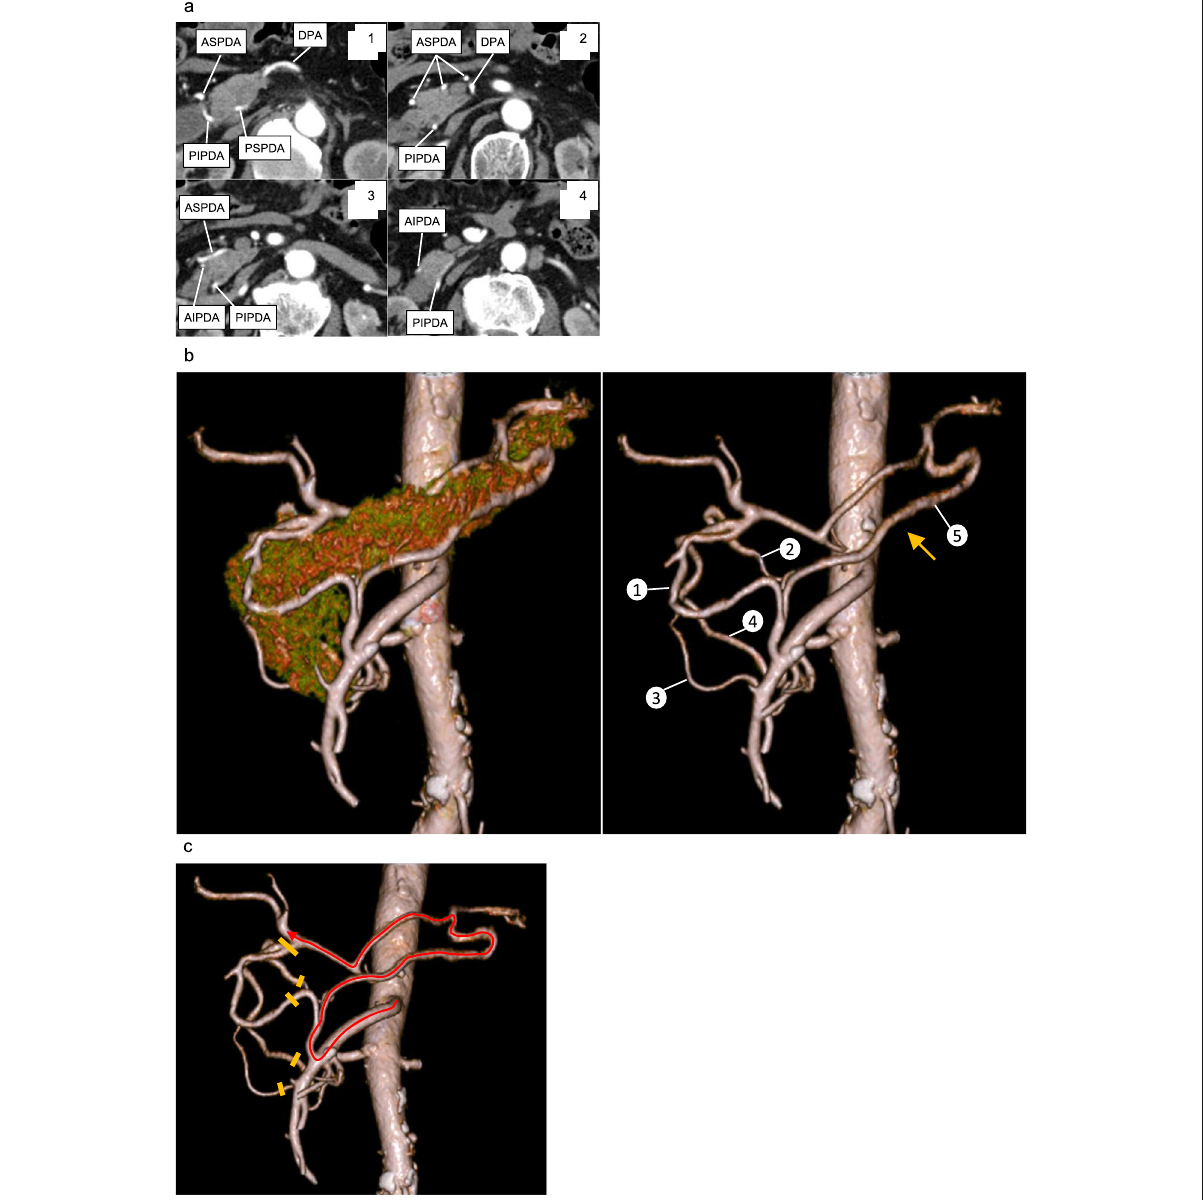
Fig. 3 Serial axial view and three-dimensional reconstruction of peri-pancreatic arterial anastomoses on the preoperative MDCT. a Serial axial view of the preoperative MDCT. Complicated arterial anastomoses from the SMA system to the CA system were detected. Images were shown from cranial to caudal section in the order from 1 to 4. b Three-dimensional reconstruction of the pancreas and artery (left) and the artery alone (right) using the preoperative MDCT. Well-developed anastomoses between the SMA and CHA through GDA, including the ASPDA (1), PSPDA (2), AIPDA (3), and PIPDA (4), were clearly detected. In addition, one well-developed anastomosis between SMA and SPA through DPA was also identified (5, arrow). c The remaining anastomosis and arterial flow from the SMA to the CHA through the DPA after division of the GDA during PD. AIPDA, anterior inferior pancreaticoduodenal artery; ASPDA, anterior superior pancreaticoduodenal artery; CA, celiac artery; DPA, dorsal pancreatic artery; GDA, gastroduodenal artery; MDCT, multi-detector computed tomography; PD, pancreaticoduodenectomy; PIPDA, posterior inferior pancreaticoduodenal artery; PSPDA, posterior superior pancreaticoduodenal artery; SMA, superior mesenteric artery; SPA, splenic